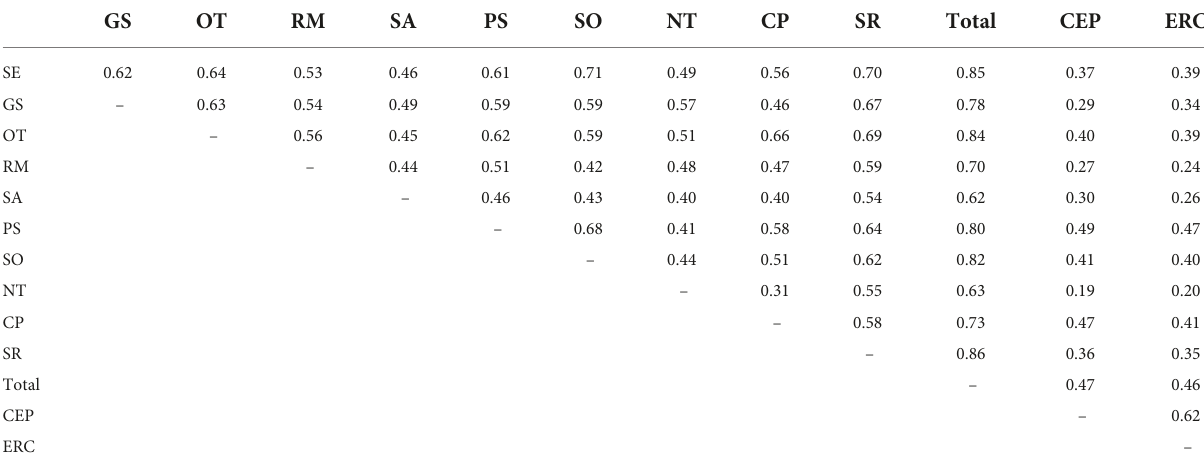
TABLE 2 Correlations between factors of SRL strategy use, comprehensive English proficiency, and English reading competence.